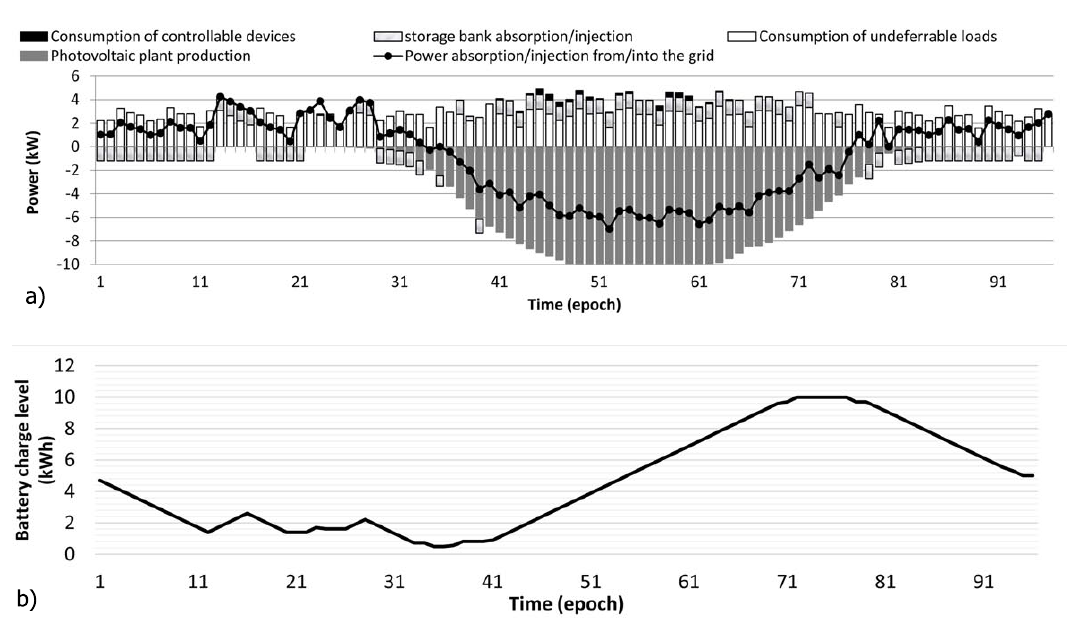
Figure 5. Energy management system (EMS) schedule of daily energy exchanges with the electricity grid and storage bank charge/discharge periods ( a ) and storage bank charge level ( b ). Positive (negative) values indicate energy purchases (sells), energy consumption (production) and battery charges